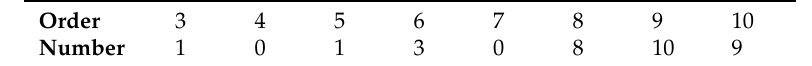
Table A2. The number of independent domination stable unicyclic graphs with different orders.